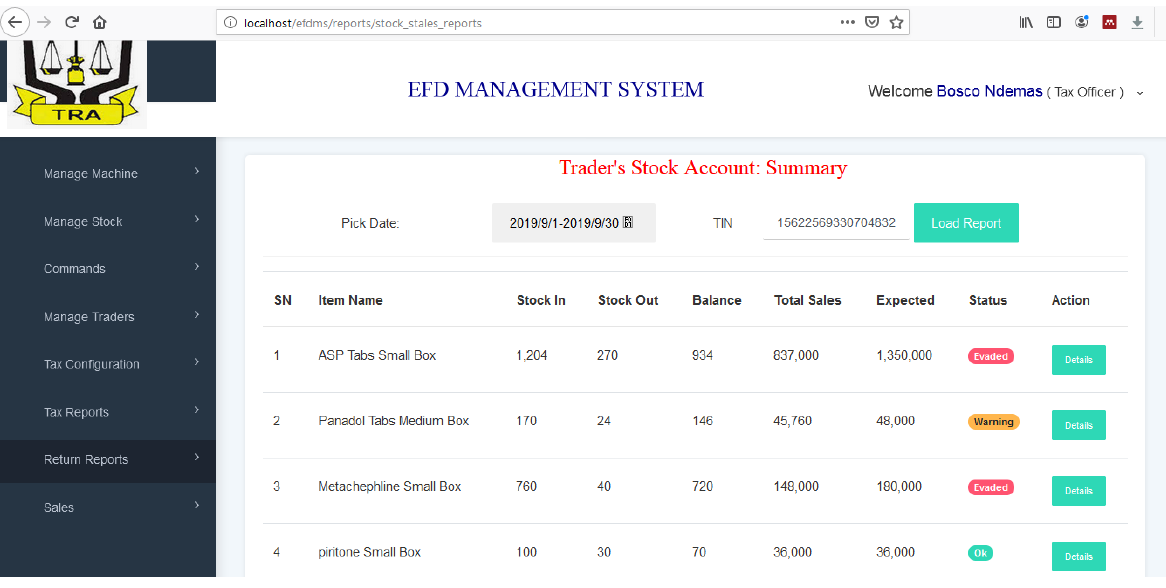
Figure 11. Traders stock account in